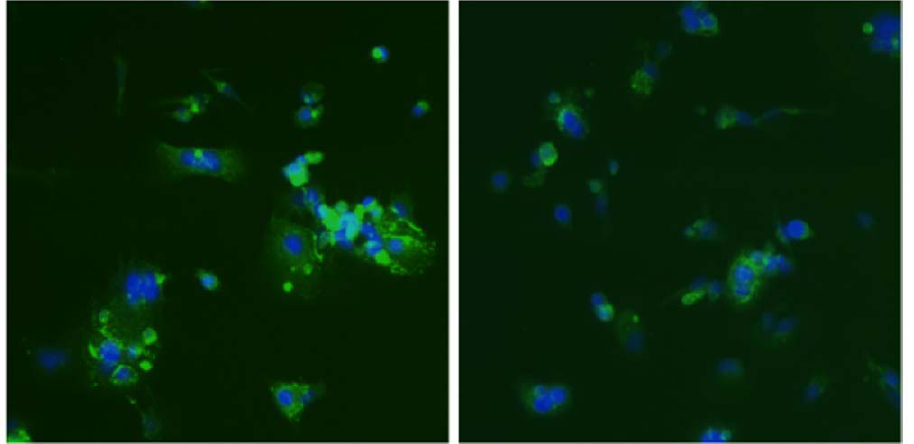
Figure 4. The effect of NR2F2 gene silencing on syncytialization of villous CTB cells. Human cytotrophoblast cells were transfected with a non-silencing (control) RNA (left panel) or a NR2F2 siRNA (right panel) as described in Figure 3. The cultures were terminated 4 days later and the cell membranes were stained with an anti-desmosomal protein antiserum (green), and the nuclei were stained with DAPI (blue) as described in Methods. 10 6